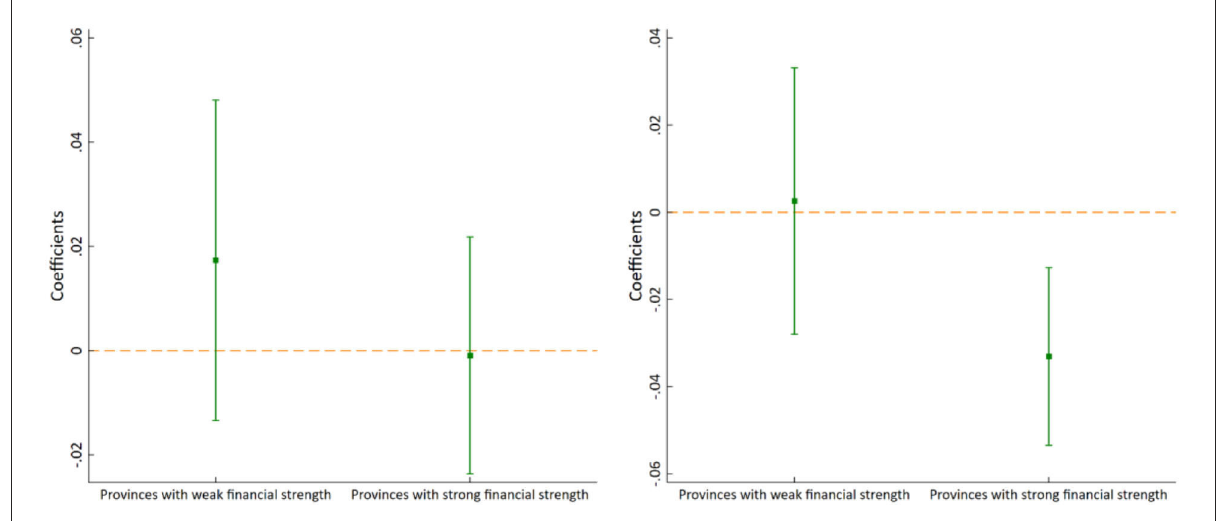
FIGURE8 Financial strength heterogeneity of ln ME_outpatient (left) and ln ME_inpatient (right)